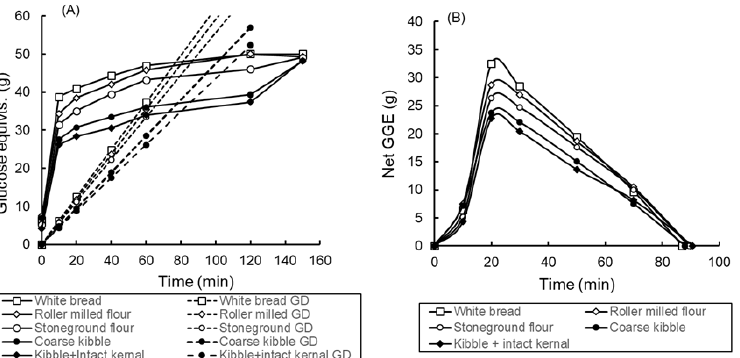
Figure 2. ( A ) Digestogram for bread samples (all 50 g available carbohydrate) containing wheat preparations differing in degree of milling. Samples were homogenised at 120 min and digestion continued to 150 min. Points are means of duplicate samples. Mean absolute deviation from mean = 1.2 g. Glucose disposal baselines (GD) for each curve are shown. ( B ) Net glycaemic glucose equivalents (GGE) were determined from the difference between each digestion curve and its corresponding GD baseline in Figure 2A. Potential available carbohydrate content in the wholegrain samples was assumed to be that measured in the homogenised, roller milled sample at 150 min.